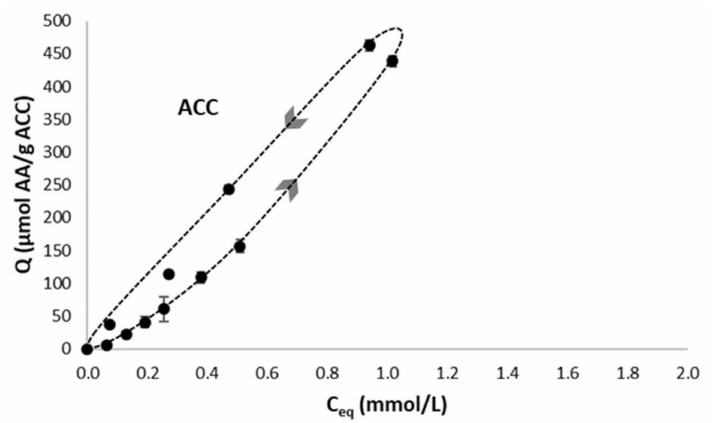
Figure 6. Aspirin adsorption-desorption isotherms on ACC